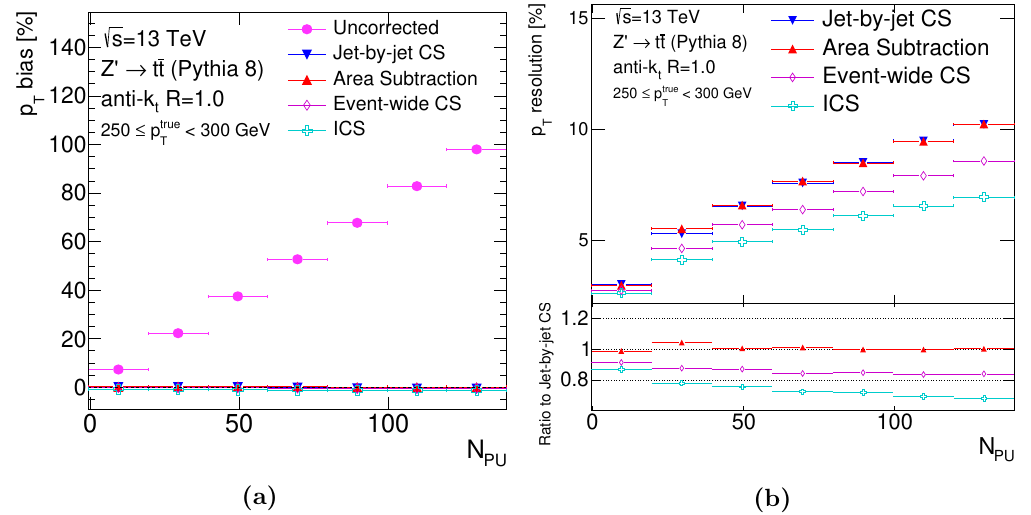
Figure 2. Dependence of jet p T bias (left) and resolution (right) on N PU for four pileup correction methods (Jet-by-jet CS, Area Subtraction, Event-wide CS, and ICS).